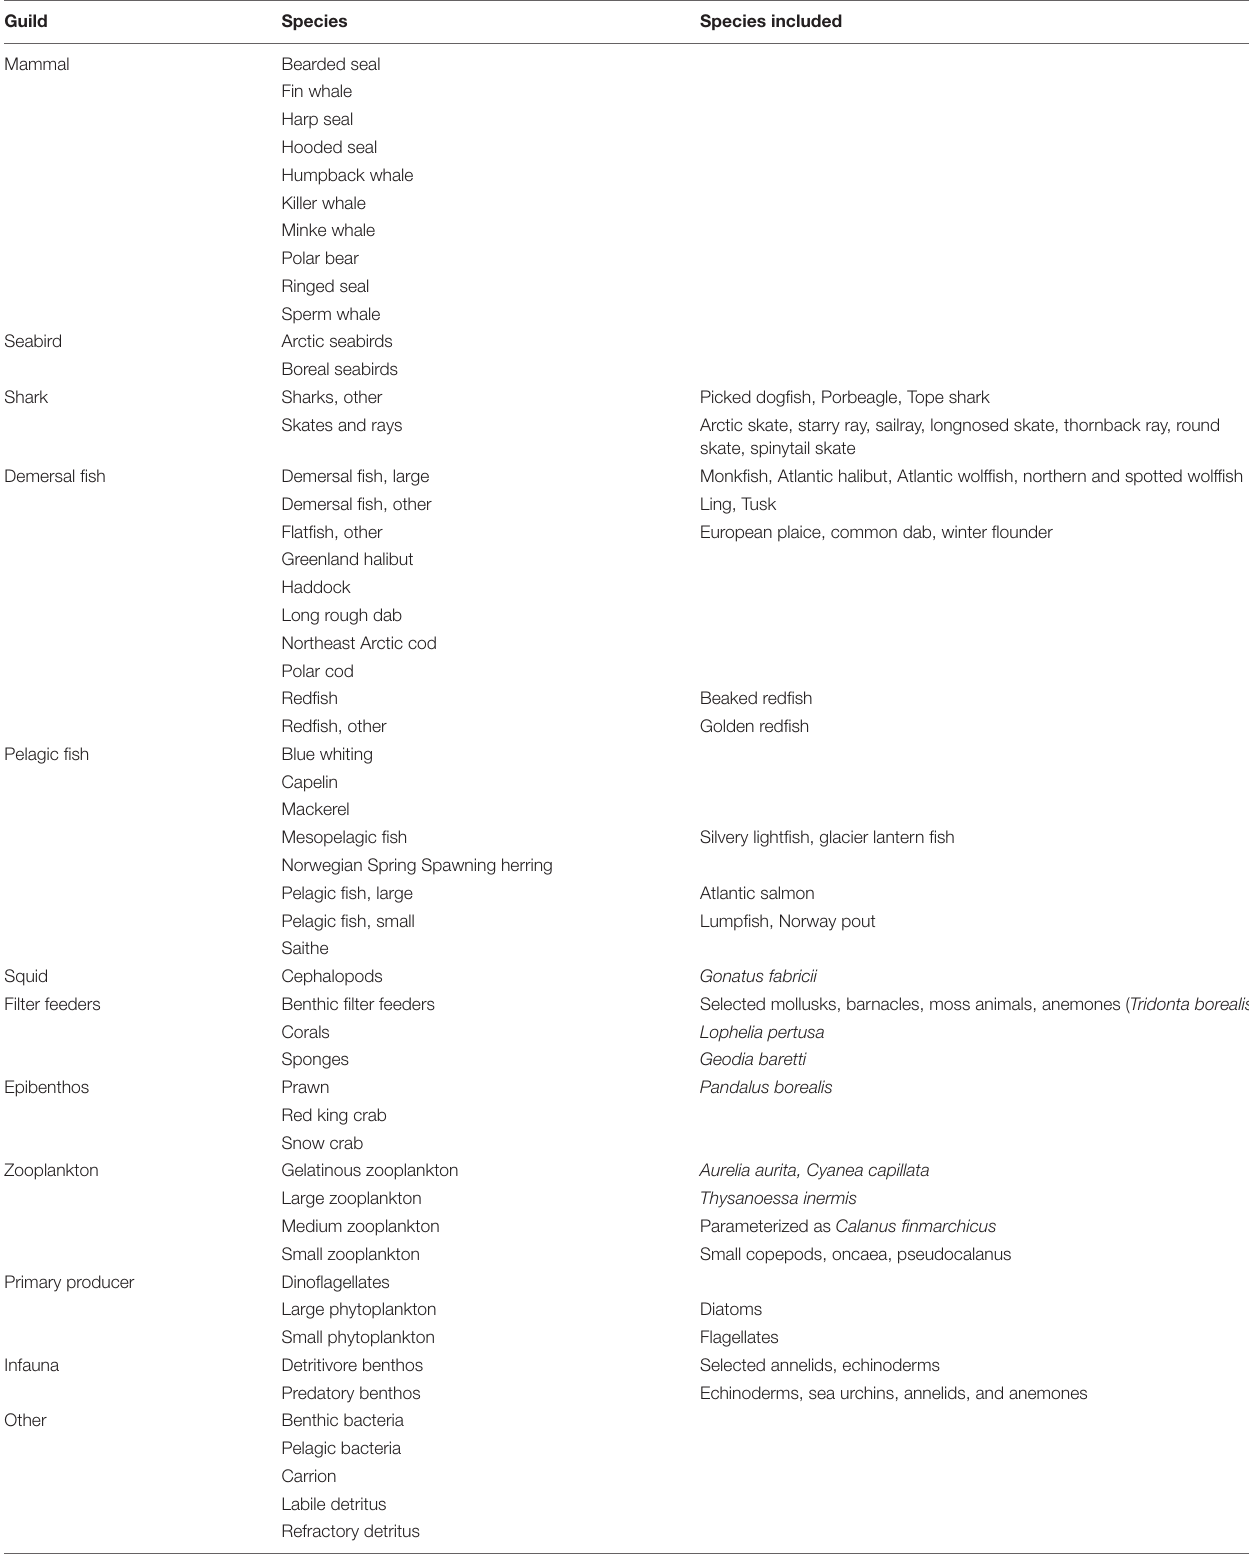
TABLE 1 | List of species and functional groups in the NoBa model, including which species the group is parameterized as. Guild Species Species included